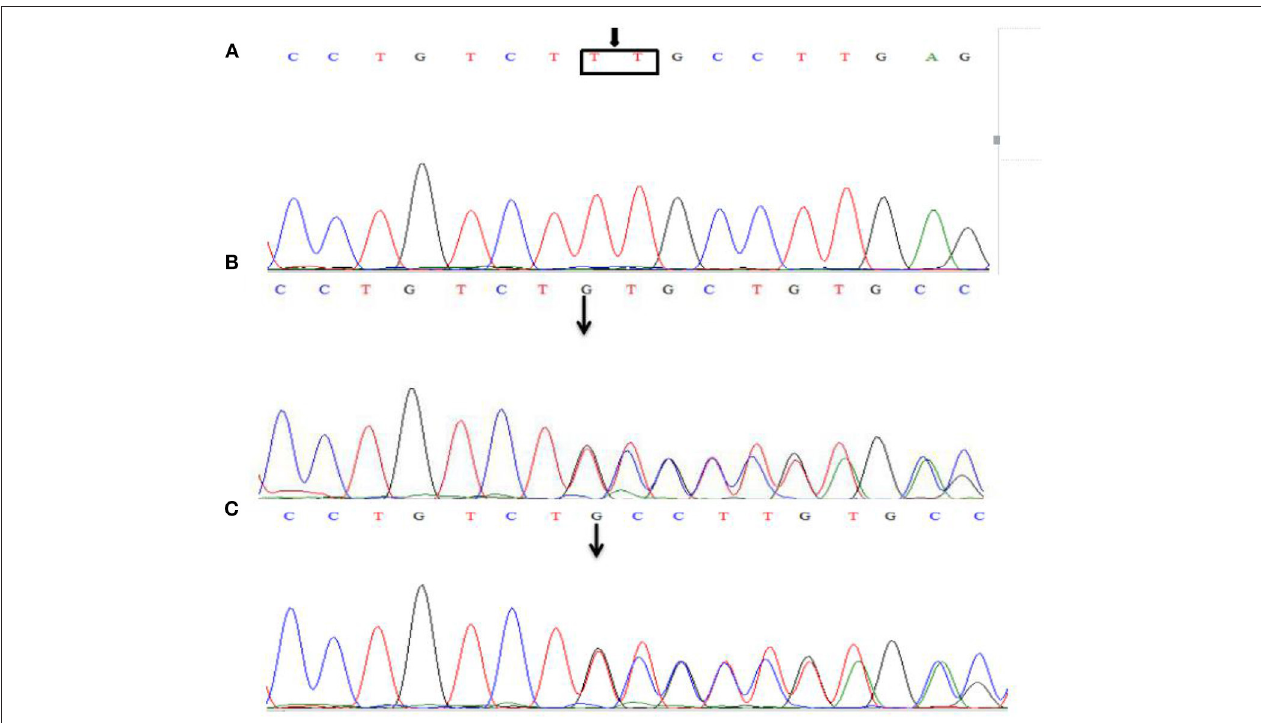
FIGURE 3 | Sanger sequencing of the LAMB2 gene. The patient was identified with 2-bp deletion; c.2044_2045insTT (A) , NM_002292.3, chr3:49163904-49163905. Both parents are heterozygous carriers (B,C) , and the arrows show the position of the mutation.